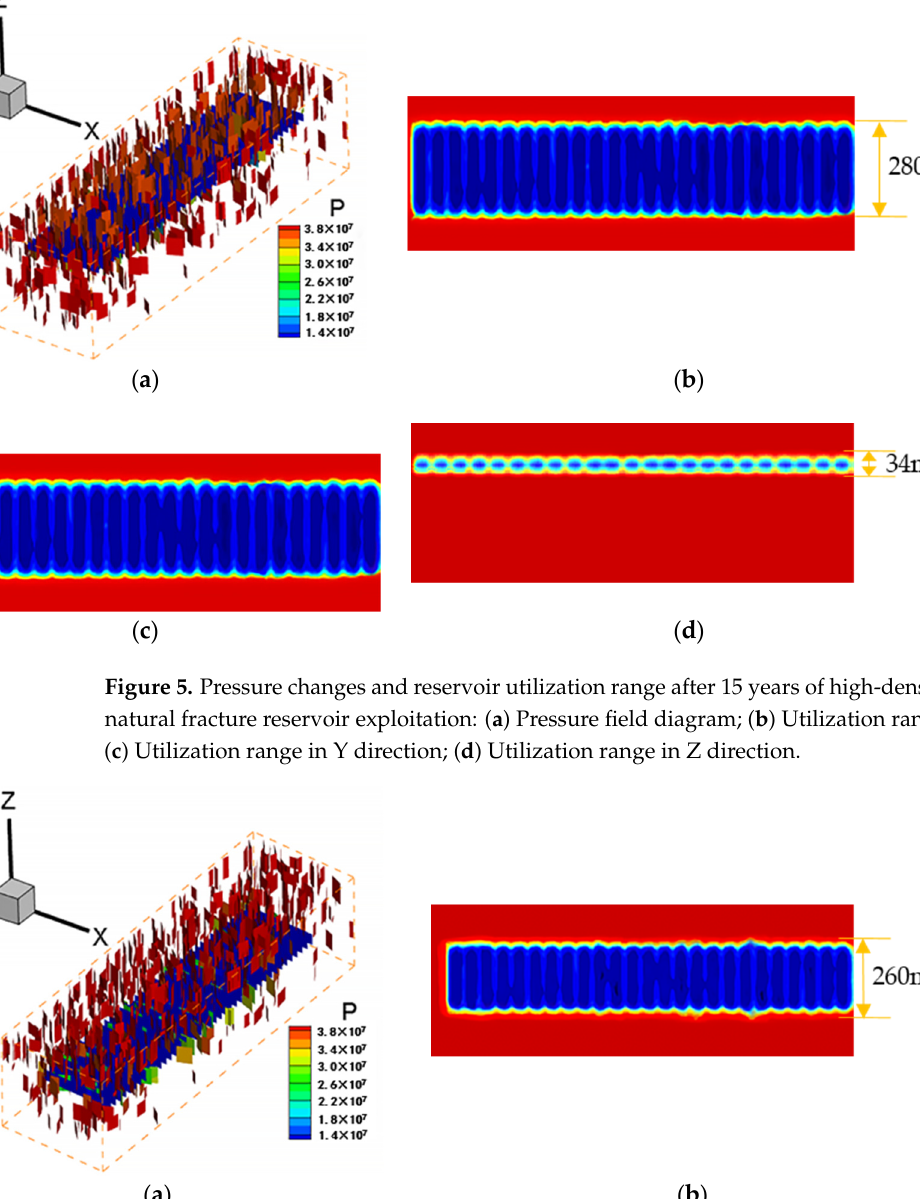
( d ) Figure 7. Pressure changes and reservoir utilization range after 15 years of low-density (0.001 m/m 2 ) natural fracture reservoir exploitation: ( a ) Pressure field diagram; ( b ) Utilization range in X direc- tion; ( c ) Utilization range in Y direction; ( d ) Utilization range in Z direction. From the simulation results, it can be seen that, for reservoirs with high-density, me- dium-density, and low-density natural fracture after 15 years of exploitation, the reservoir utilization ranges in the X direction are 280 m, 260 m, and 240 m, in the Y direction they are 50 m, 45 m, and 40 m, and in the Z direction they are 34 m, 32 m, and 30 m. Figure 8 shows the production of the well at high-density, medium-density, and low- density natural fractures. As shown above, the density of natural fractures affects the productivity of the well. The well productivity of the high-density (0.012 m/m 2 ) natural fractures reservoir > the well productivity of the medium-density (0.006 m/m 2 ) natural fractures reservoir > the well productivity of the low-density (0.001 m/m 2 ) natural frac- tures reservoir.